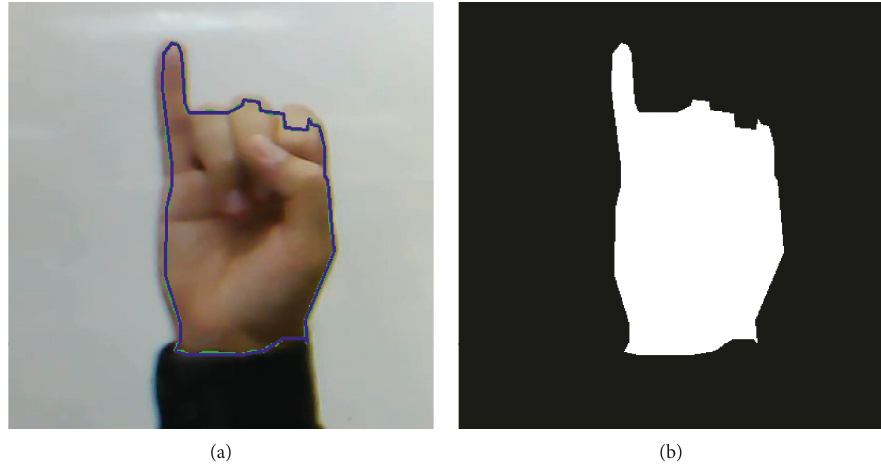
Figure 9: Image and its hand contours (a) and the final hand segmentation (b).